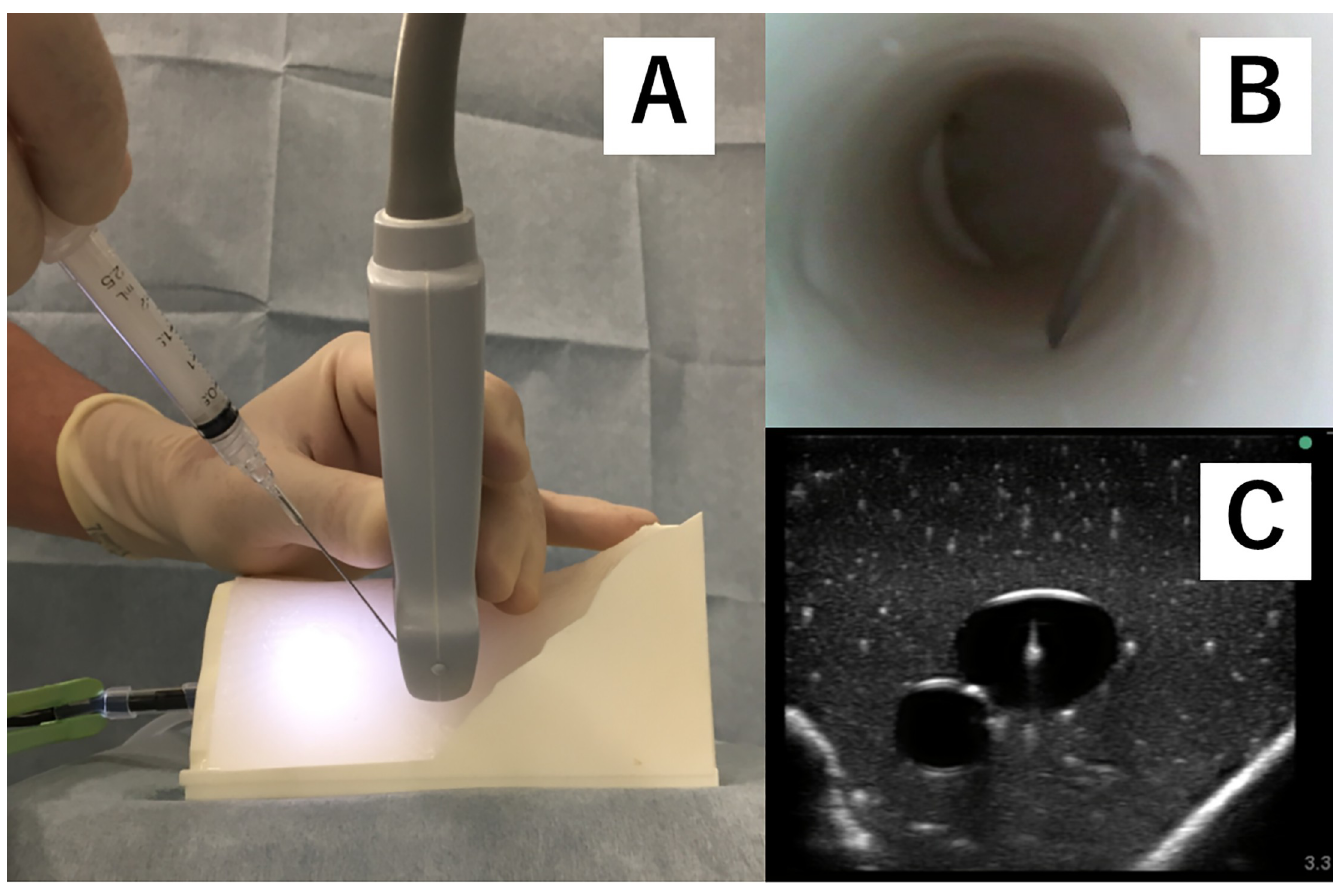
Fig 3. Free-hand short-axis out-of-plane approach. Panel A: Needle insertion starts close to the ultrasound probe, and the angle of approach is relatively steep, according to the guidelines of the American Society of Echocardiography and the Society of Cardiovascular Anesthesiologists. Panel B: Internal view of the simulated vein. Panel C: Ultrasound-view of the simulated